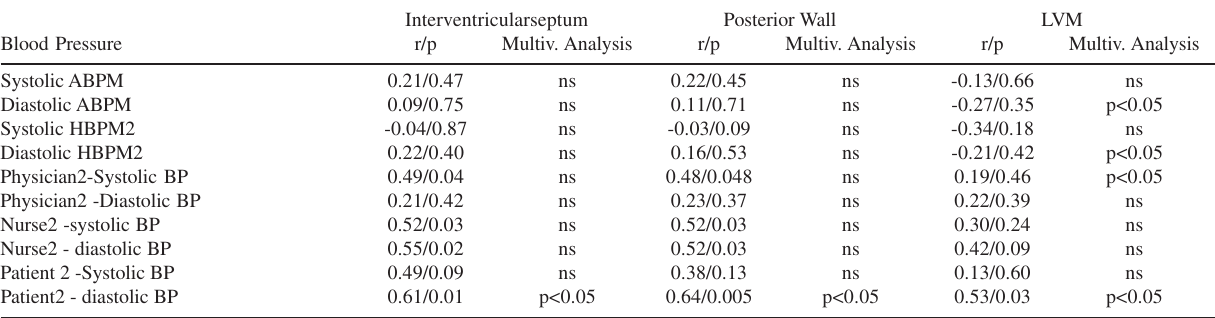
Table 2 - Multivariate analysis and correlation (r value / p value) between posterior wall dimensions, interventricular septum and left ventricular mass (LVM) and Home2, HBPM2 and